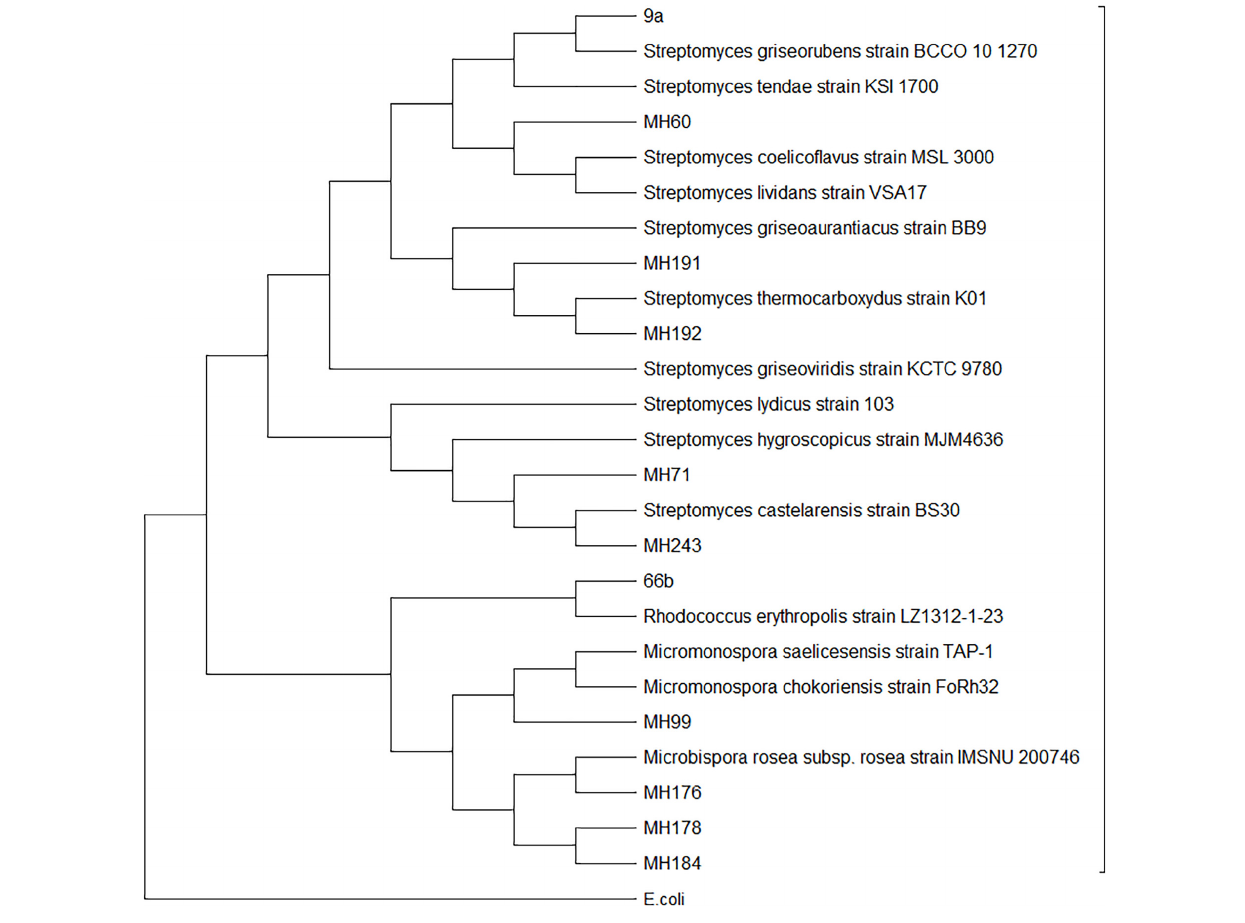
FIGURE 2 | Molecular phylogenetic analysis of Actinobacteria isolates based on 16s rDNA sequences by Maximum Likelihood